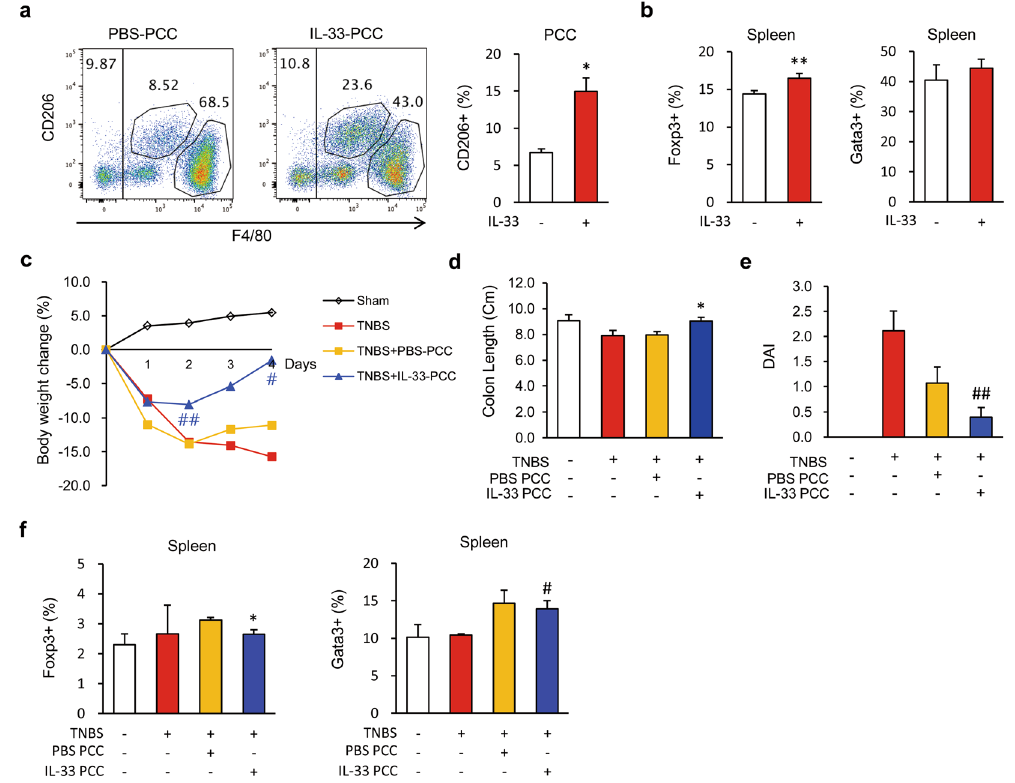
Figure 4. IL-33-treated peritoneal cavity cells ameliorate mouse colitis. Male C57BL/6 mice were inoculated i.p. with IL-33 (mrIL-33, 1 μ g/mouse) or PBS for 3 consecutive days. Next, peritoneal cavity cells (PCCs) were extracted from the peritoneum of each mouse by washing the peritoneal cavity with cold PBS ( a , b ). F4/80 positive cells were sorted from the harvested PCCs and i.p. injected (1 × 10 6 cells) into recipient mice. After 2 days, 2,4,6-trinitrobenzenesulfonic acid (TNBS) solution (2.2% (w/v)) was injected into the colon of each recipient mouse ( c – f ). ( a , b ) Representative flow cytometry plots of PCCs and spleen cells from IL-33-treated naïve mice. ( a ) Dot plot of the M2 (CD206 + ) macrophage (F4/80 + ) populations in the PCCs and percentages of the M2 macrophage populations in the PCCs. ( b ) Treg (Foxp3 + ) and Th1 (Gata3 + ) populations in the spleens of naïve mice. ( c ) Body weight changes of PCC-transplanted mice. ( d ) Colon lengths of PCC-transplanted mice. ( e ) Disease activity index (DAI) scores of PCC-transplanted mice. ( f ) Flow cytometry analysis of Treg (Foxp3 + ) and Th1 (Gata3 + ) populations isolated from the spleen of PCC-transplanted mice. Values are expressed as means (n = 5); error bars represent ± SD. # P < 0.05 vs. TNBS, ## P < 0.01 vs. TNBS, * P < 0.05 vs. Veh or PBS PCC, ** P < 0.01 vs. Veh or PBS PCC as assessed by ANOVA. Veh, injected with vehicle; IL-33, injected with mrIL-33; PCC, injected with F4/80 + PCCs; TNBS, injected with